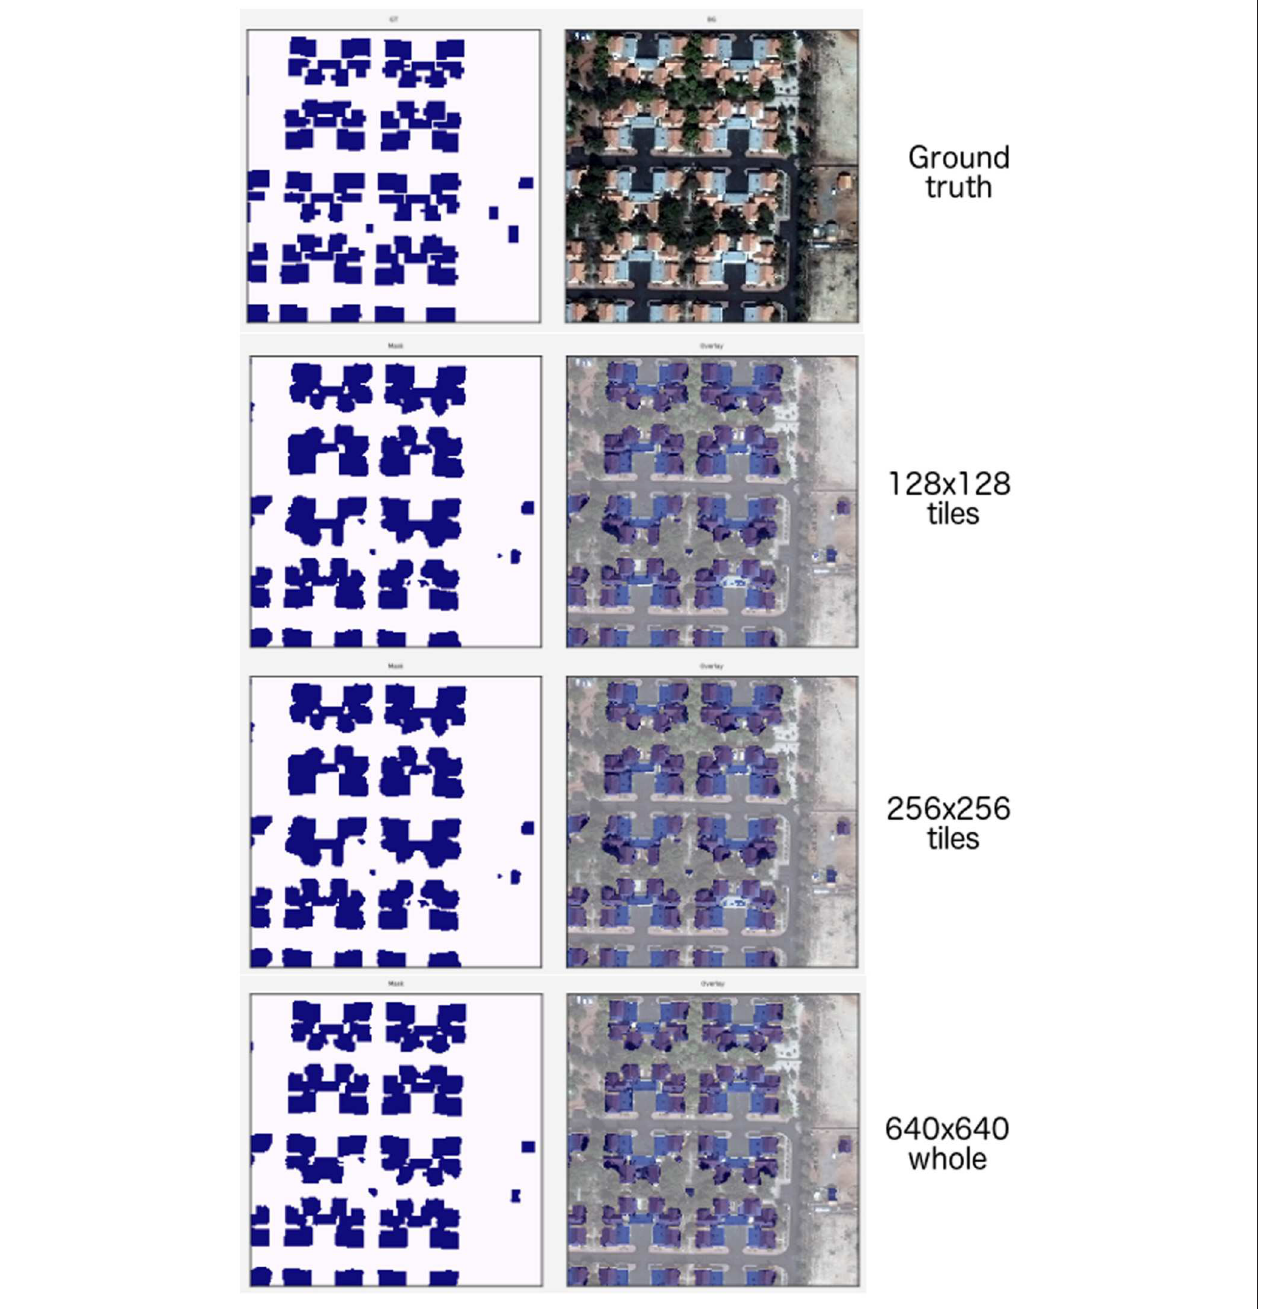
FIGURE 11 | (1st row) Ground truth and whole image. (2nd row) 128 × 128 tiles. (3rd row) 256 × 256 tiles. (4th row) 640 × 640 whole